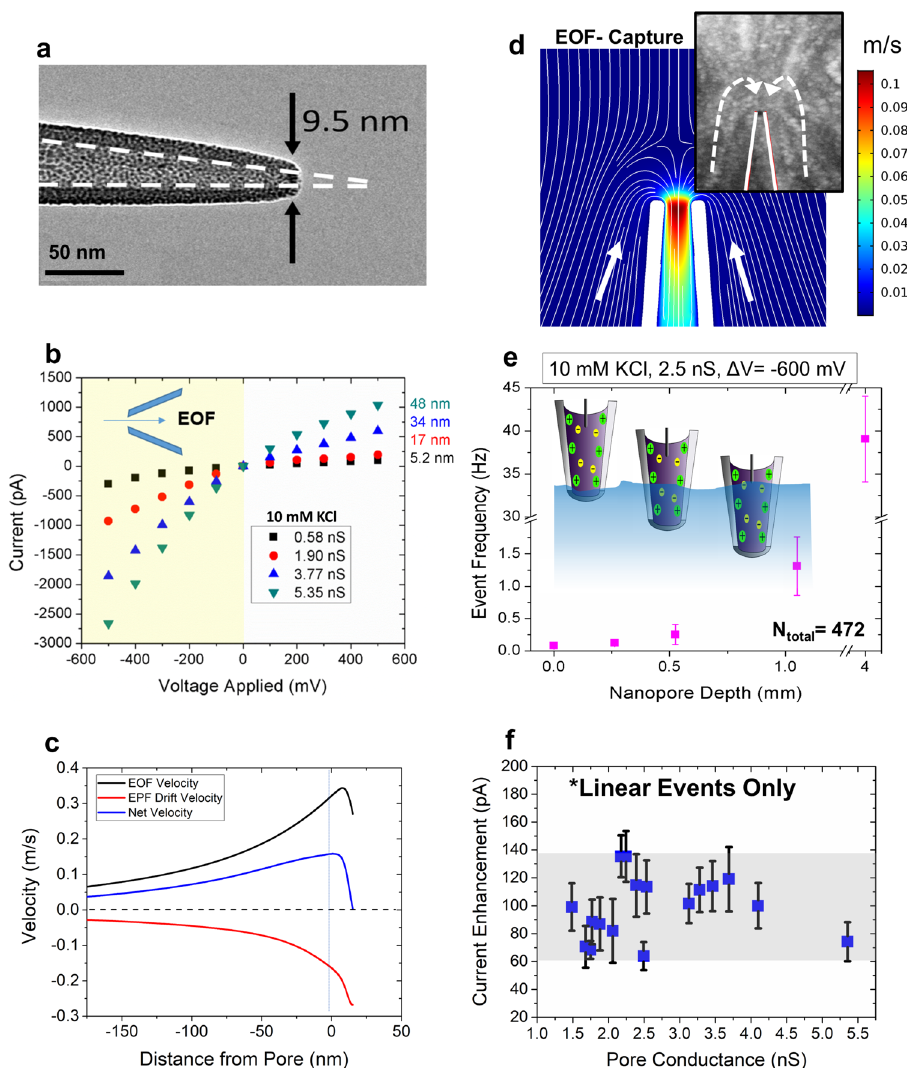
Fig. 1 Experimental set-up and characterization of quartz nanopores. a TEM of quartz nanopore; scale bar, 50 nm. b I – V curves pertaining to four differently sized nanopipette ori fi ces. For pore size estimations, the linear portion at the negative voltages was used (yellow shaded region). The schematic within the I – V curves shows the directionality of EOF and EPF at negative voltages. c EOF, EPF drift, and the resulting net velocities of λ -DNA along the pore ’ s axis of symmetry ( μ = 3.2 × 10 4 cm/Vs). Distance from the pore is radial from the axis of symmetry. d Simulations of fl uid fl ow velocities under low ionic strength conditions. White lines indicate fl uid fl ow lines for a 20 nm pore at − 600 mV voltage bias. Inset: YOYO-labeled DNA sample with an applied voltage of − 700 mV to visualize the capture zone. e Event frequency with depth of the pipette inside the bath solution. Nanopore depth is synonymous with how deep the nanopore tip was submerged into the analyte-containing bath solution. Error bars show the standard deviation of each condition. f Linear DNA events from 17 pores were investigated for pore size dependence on current amplitude. We see that the enhancements fl uctuate between 60 and 140 pA with no discernable trend. Errors bars represent the standard deviation of the current